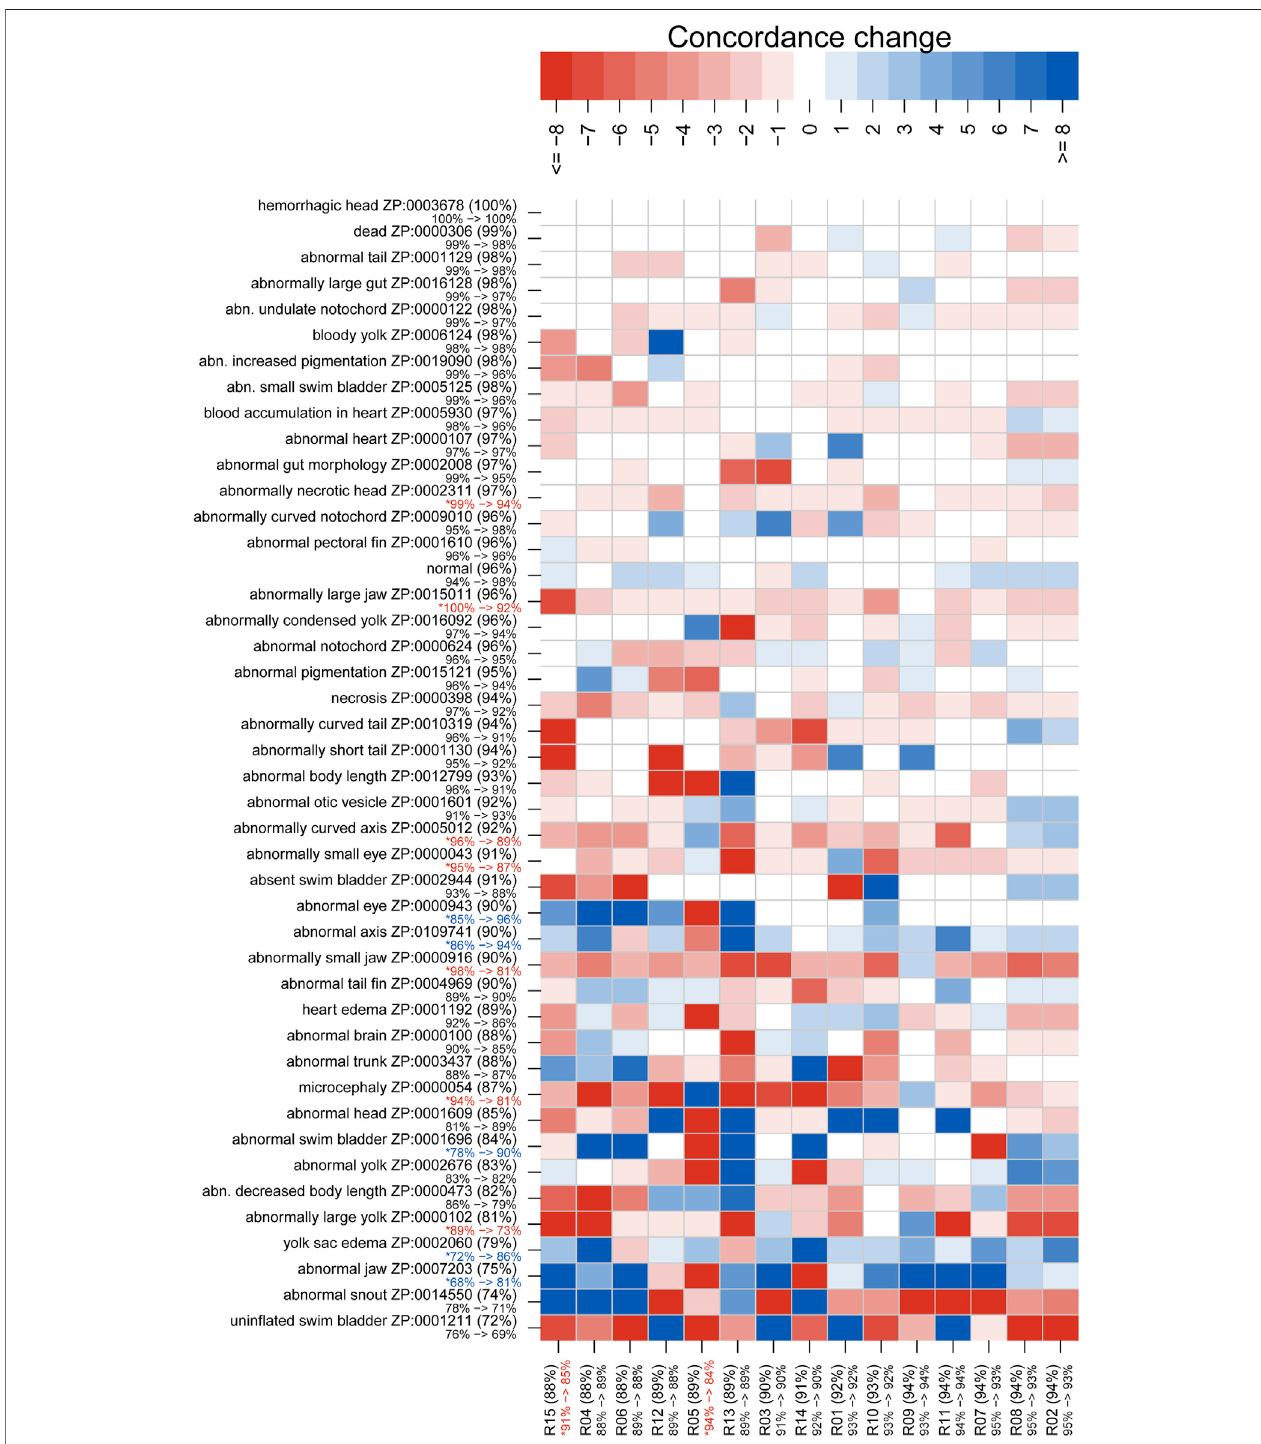
FIGURE 6 | Concordance change for granular phenotype terms. Concordance here means the rater made the same annotation as the majority of raters. The “ concordance change ” isthe differencebetween thenumber of concordant calls for Survey 2 and those for Survey 1 (maximum values would range from − 24 to24). An increase in concordance is indicated by blue and a decrease is indicated by red. The annotation and rater labels have the overall mean concordance in parentheses (combinesbothsurveys),andacolor-codedchangeinmeanconcordancefromSurvey1toSurvey2justbelow.Notethatthelowerboundfortheannotationmean concordance is 50%, but the rater lower bound is 0%. Axes are sorted by overall mean concordance values. Signi fi cant changes in concordance as determined by Fisher ’ s exact tests are indicated by an asterisk.